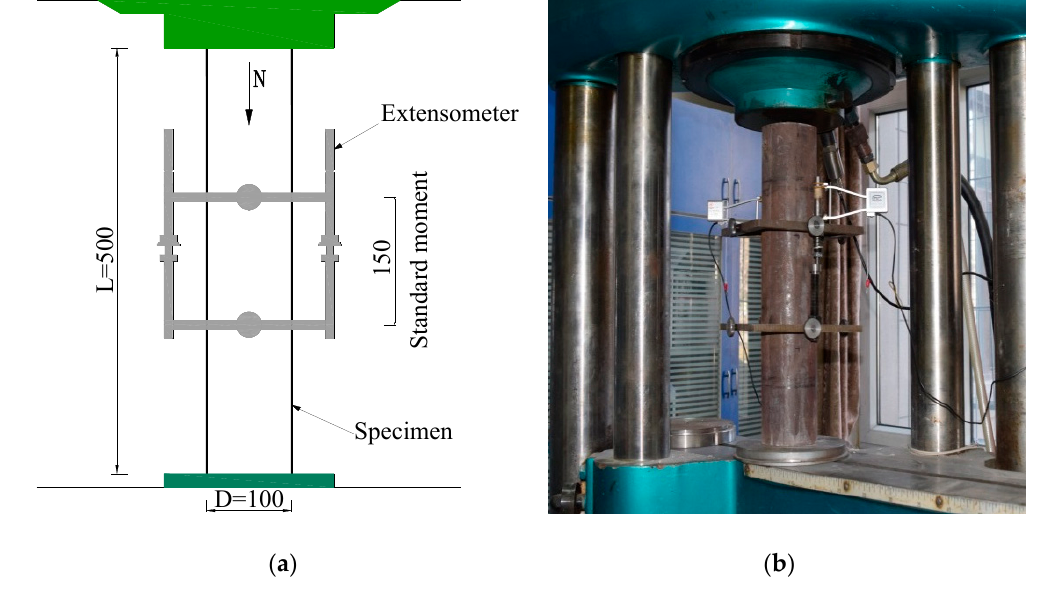
Figure 7. Test set-up. ( a ) Sketch map of the test; ( b ) Scene photos of the test.